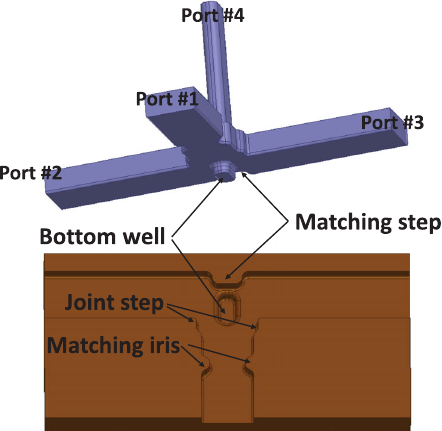
FIG. 29. Wakefield of the new CLIC-G accelerating structure with the HOMagic-T design: (a) linear scale; (b) enveloped value in log